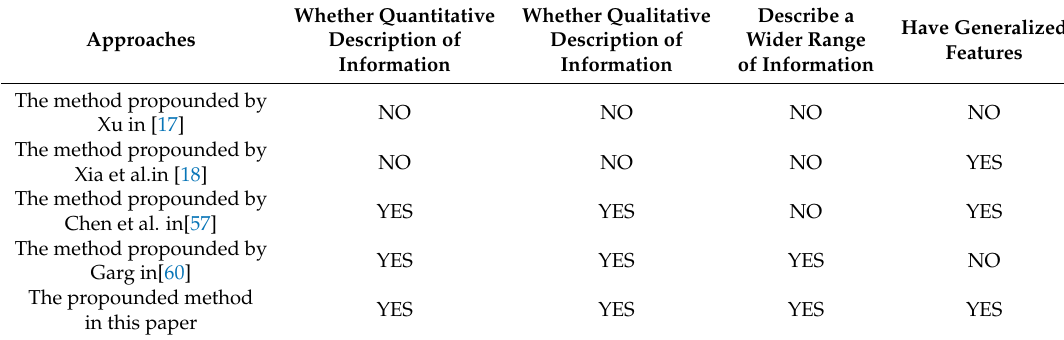
Table 11. Feature comparison for different